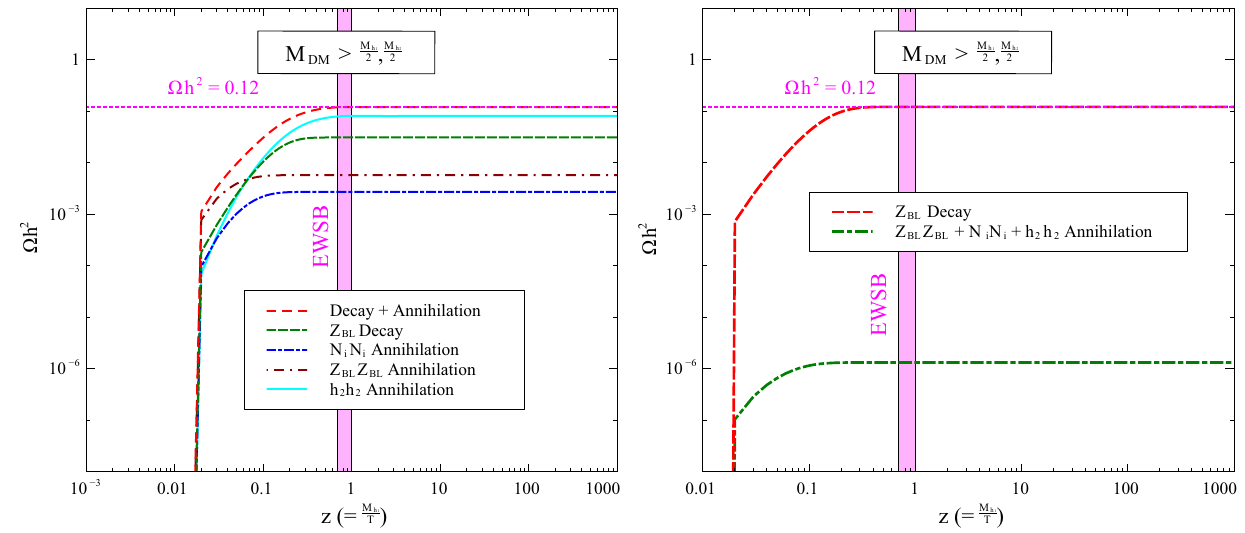
Fig. 13 Left (Right) panel: Variation of the DM relic density (cid:9) h 2 with z . The other parameter values have been kept fixed at λ Dh = 2 . 574 × 10 − 12 (7 . 212 × 10 − 14 ), λ DH = 3 . 035 × 10 − 11 (8 . 316 × 10 − 14 ),